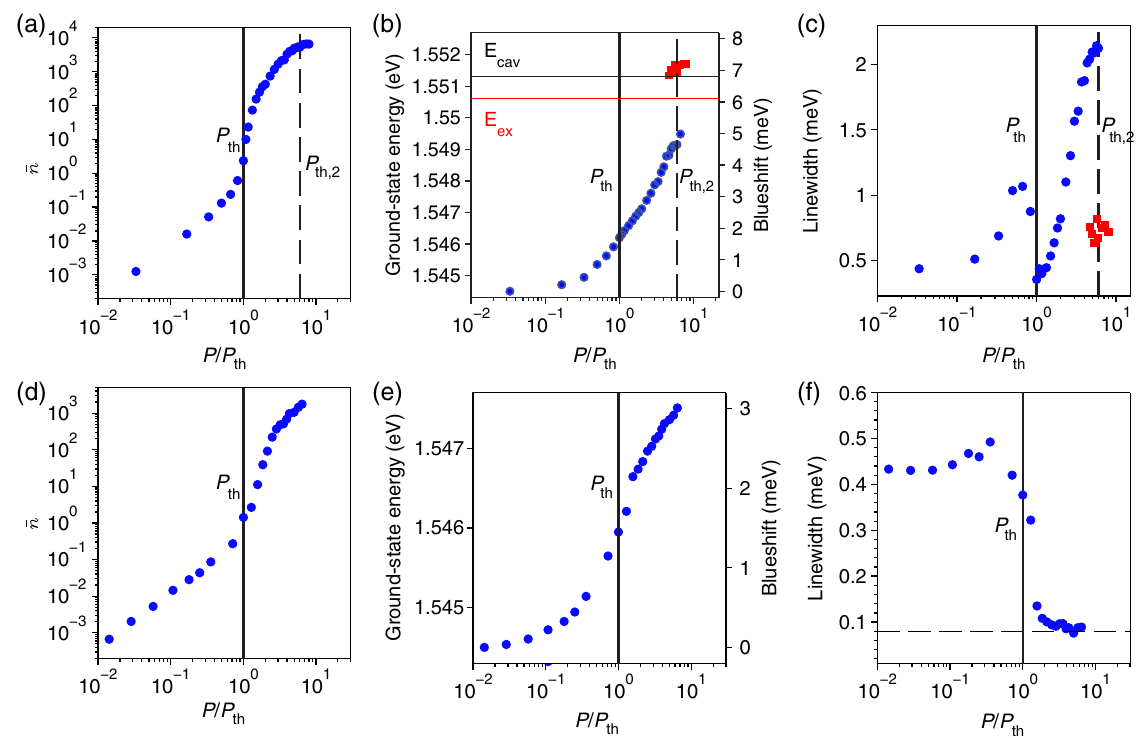
FIG. 2. Intensity and spectral properties of the single-mode polariton laser. (a) The occupation number vs P=P P indicates the threshold for polariton lasing, and P indicates the threshold for photon lasing. The ¯ n is estimated from the th th ; 2 independently measured PL intensity from the ground state, collection and detection efficiencies of the setup, and the polariton lifetime [4,6]. (b) Energy and blueshift of the polariton ground state (dots) and lasing photon mode (squares) vs the normalized pump powers P=P for pulsed excitation. Here, P is the pump power at the polariton lasing threshold. The solid vertical line marks the polariton th th lasing threshold, and the dashed vertical line marks the photon lasing threshold. (c) The linewidth (full width at half maximum) of the polariton ground state vs P=P for pulsed excitation. (d) – (f) The occupation number, blueshift, and linewidth of the polariton ground th state vs P=P for CW excitation. The dashed line in (f) represents the spectral resolution of the monochromator of about 0.08 th